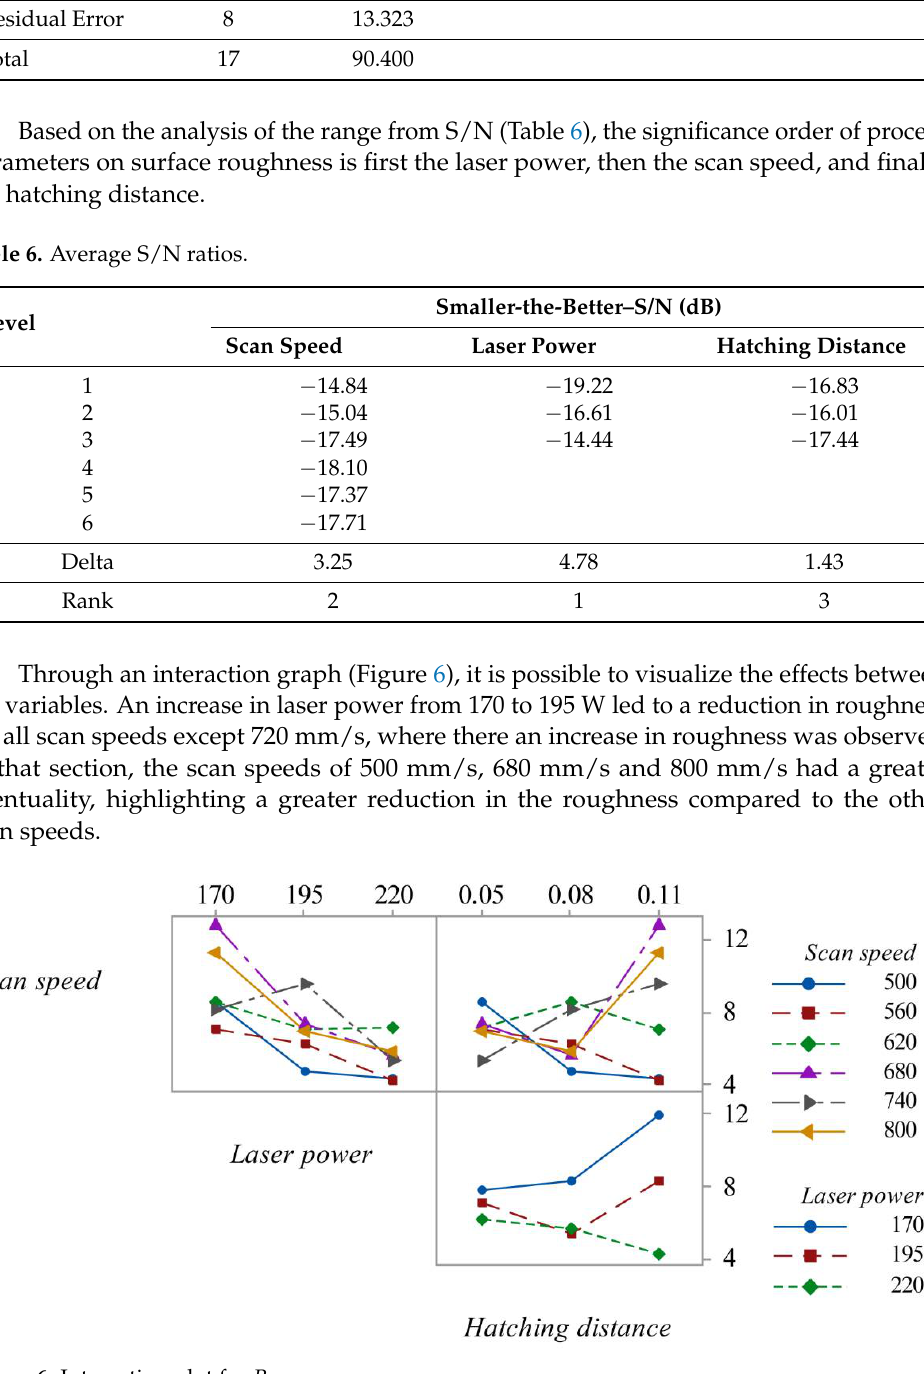
Figure 6. Interaction plot for R a . Considering the effect of the hatching distance, its increase from 0.05 mm to 0.08 mm led to a reduction in roughness by about half for a speed of 500 mm/s. A less pronounced reduction was observed for a scan speed of 680 mm/s and 800 mm/s. For these last two